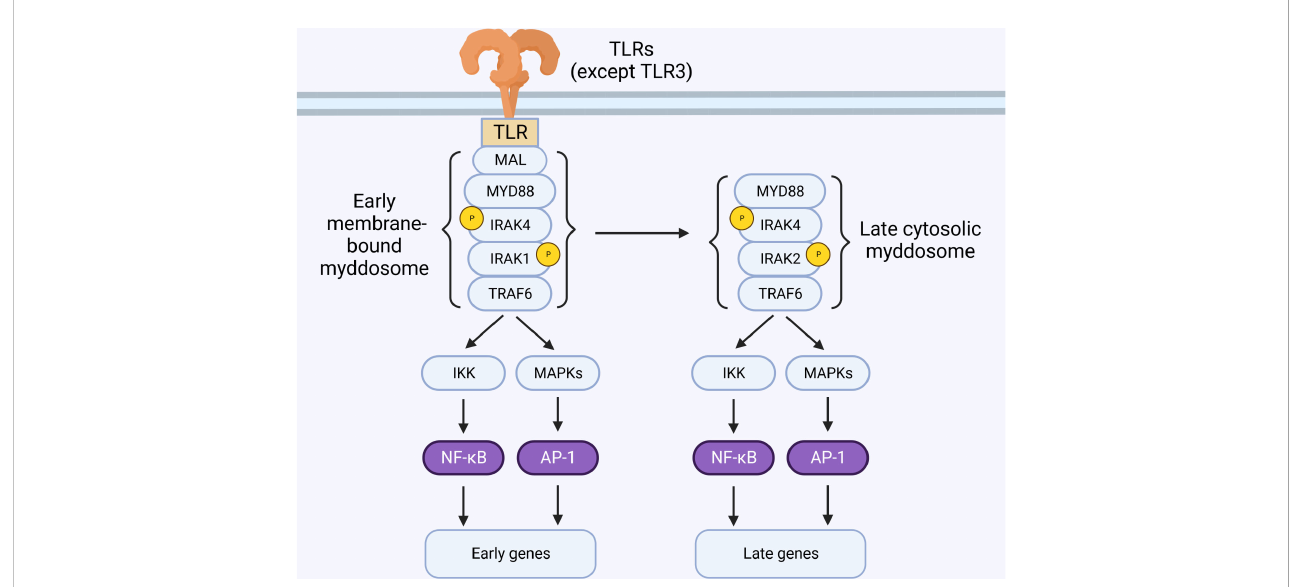
FIGURE 4 IRAK2 is essential for late-phase TLR signaling. TLR activation at the membrane triggers the sequential recruitment of Mal, MyD88, IRAK4, IRAK1 and TRAF6, forming the myddosome. These early membrane-bound complexes are short-lived and detectable only within minutes of stimulation. Sustained TLR stimulation leads to formation of cytosolic myddosomes containing